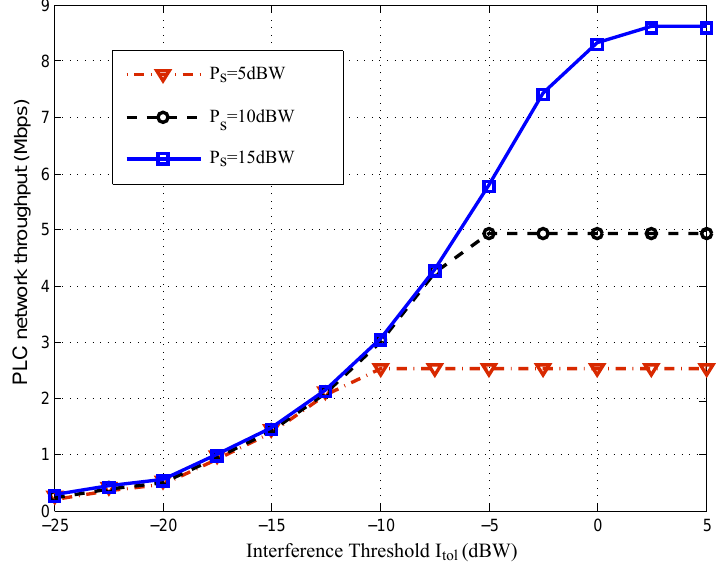
Figure 3. The PLC system throughput with the interference threshold I tol under different transmit